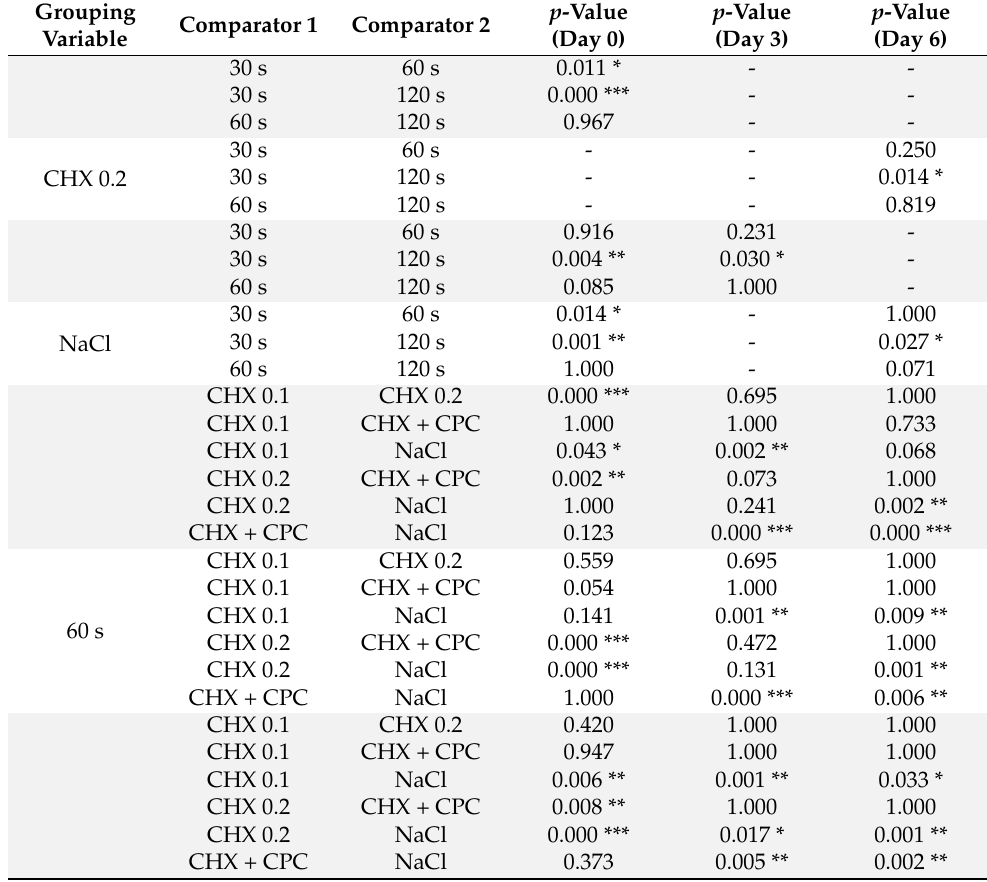
Table 2. Cytotoxicity. A multiple Kruskal-Wallis test was performed to compare the groups at each time point (i.e., at day 0, 3 and 6), and in the case of significance, a post hoc multiple comparison test with Bonferroni p -value adjustment was performed. The adjusted p -values from post hoc test are reported and labeled as follows: * p < 0.05, ** p < 0.01, *** p <